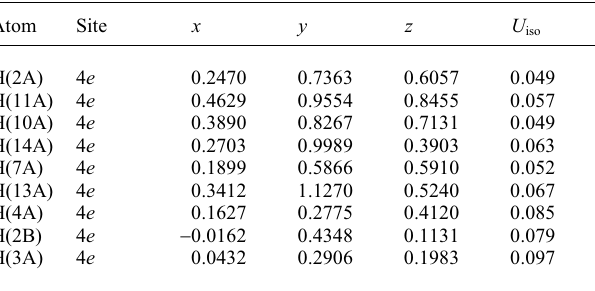
Table 2. Atomic coordinates and displacement parameters (in Å 2 ) .